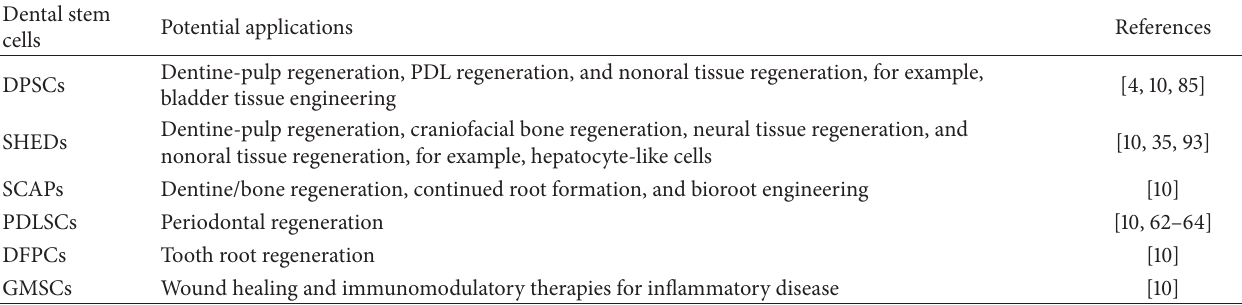
Table 2: The different types of dental stem cells and their potential applications in regenerative medicine are